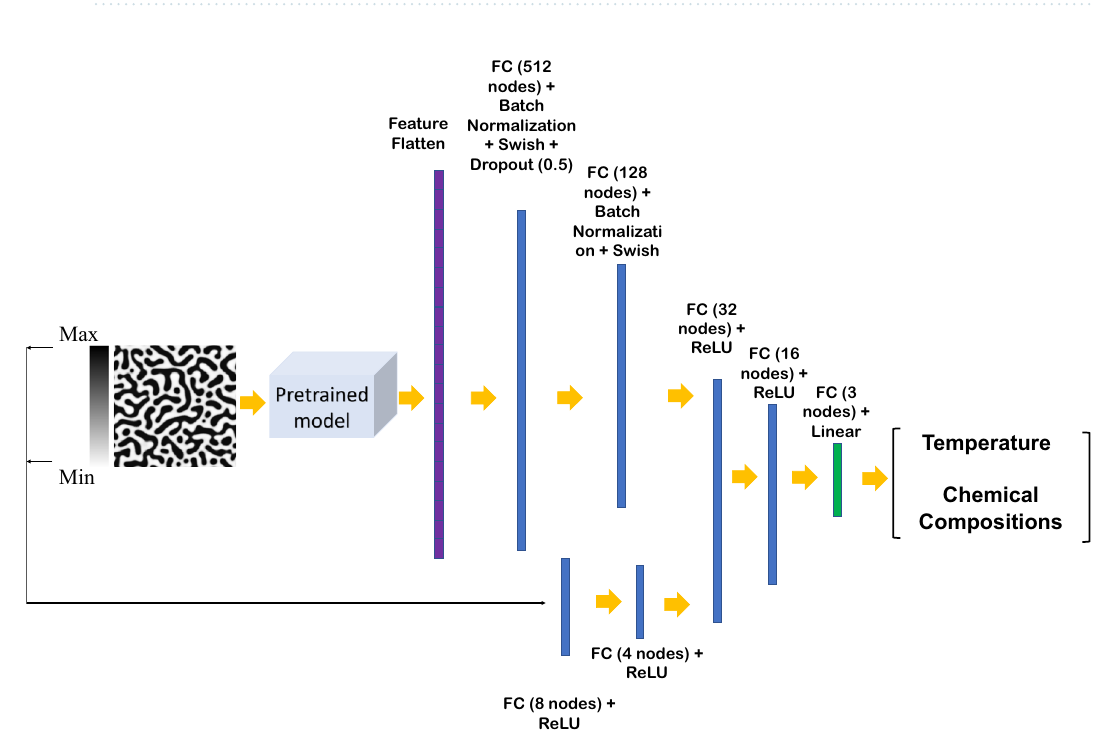
Figure 7. The architecture of the proposed model (input image size is 224 × 224